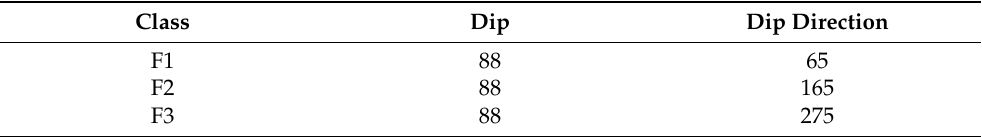
Figure 8. A different representation of the aspect of the rock faces, showing only the three main orientation groups, which define the three simplified rock face configurations employed in the traditional Markland’s stereoplot tests. Table 2. Pairs of dip and dip direction values used to simplify the complex morphology of the rock faces into three faces (F) only. Class Dip Dip Direction F1 88 65 F2 88 165 F3 88